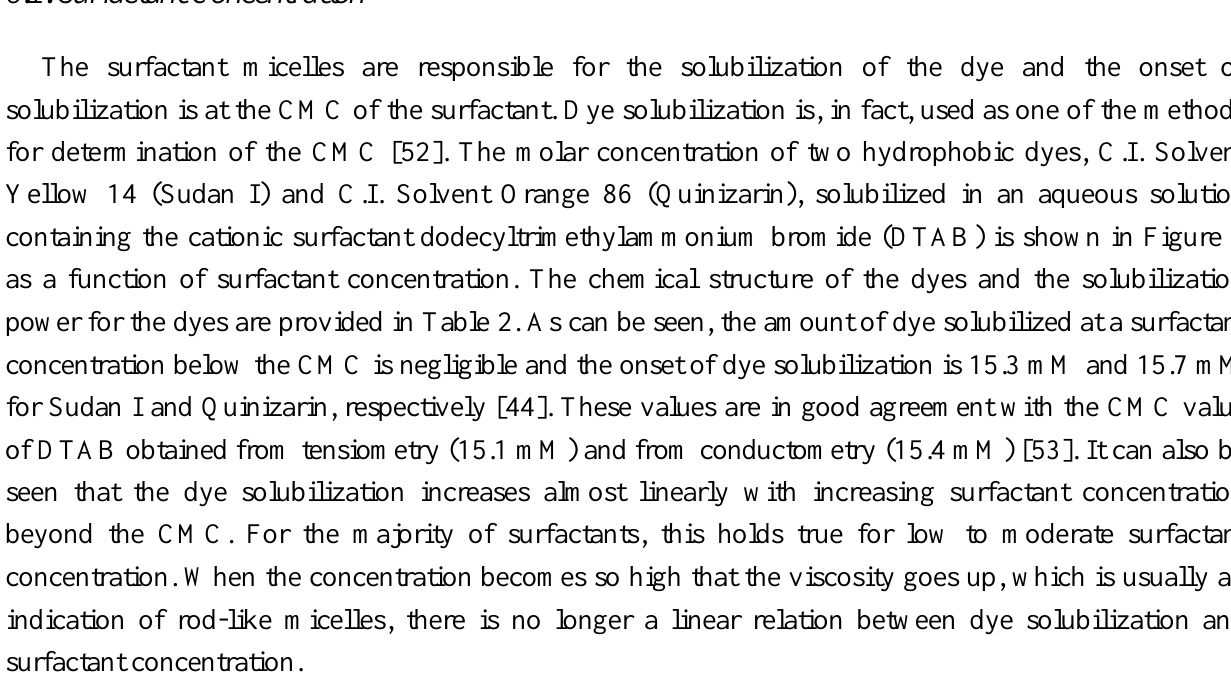
Figure 5. Solubilization of two hydrophobic dyes C.I. Solvent Yellow 14 (Sudan I) and